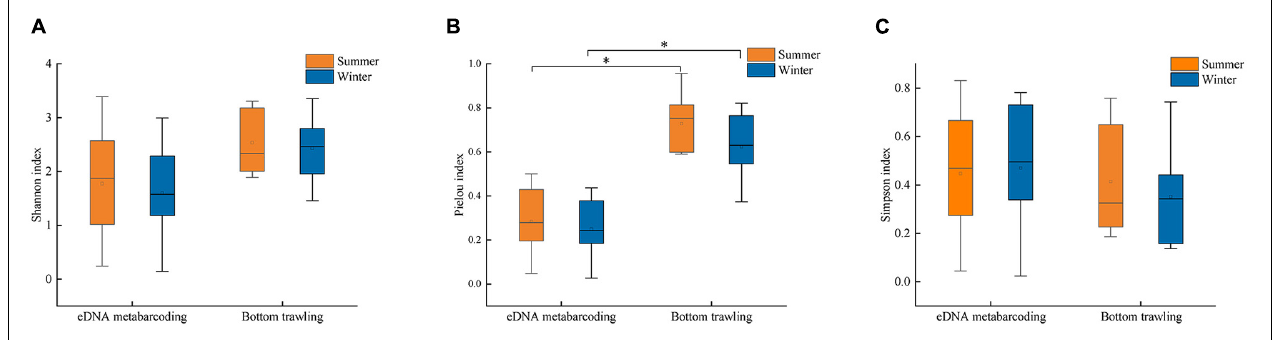
FIGURE 8 | Summer and winter fish biodiversity indices: (A) Shannon index, (B) Pielou index, (C) Simpson index ( ∗ indicates p < 0.05) in the Zhoushan Sea